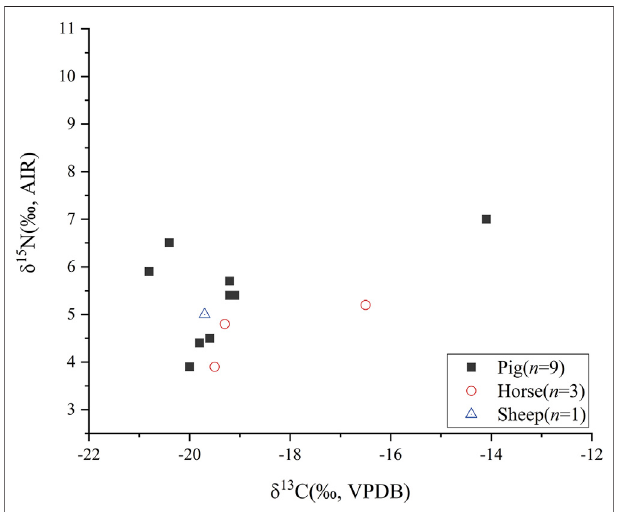
FIGURE 5 | Scatter plot of the stable isotopes of animal bones from the Changshan site during the Liaojin